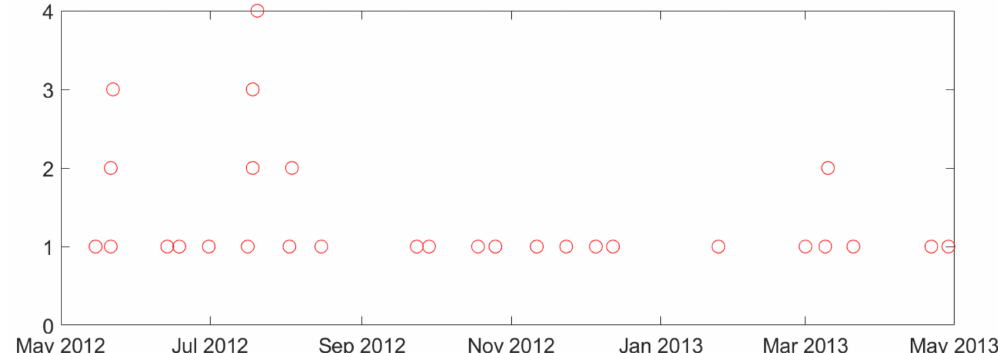
Figure A2. Clustering of seizures for canine data (M3): Explanation: among all 29 seizures (shown in red circles), 11 seizures occur in clusters, 18 seizures are isolated. Using T = 3 days, 22 clusters (~lead seizures) can be detected. Cluster duration is between 1 to 4 days, duration between two lead seizures is between 5 and 43 days.